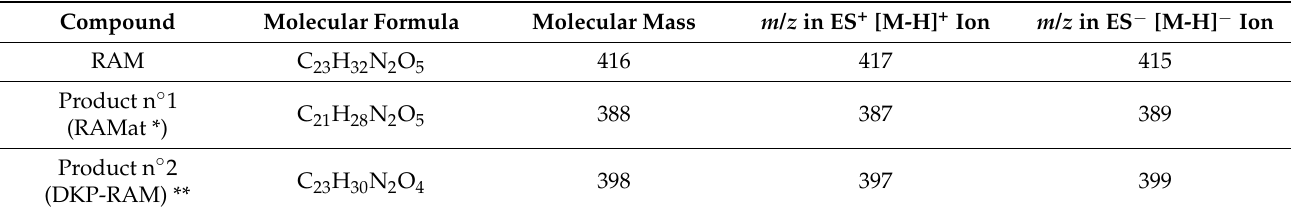
Table 6. Identification of RAM decomposition products (T = 363 K, RH = 76%) by the analysis of m / z values from mass spectra.